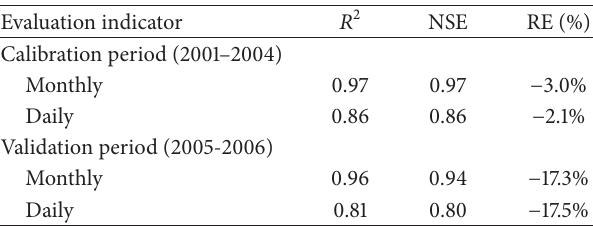
Table 4: Model evaluated statistics for calibration period